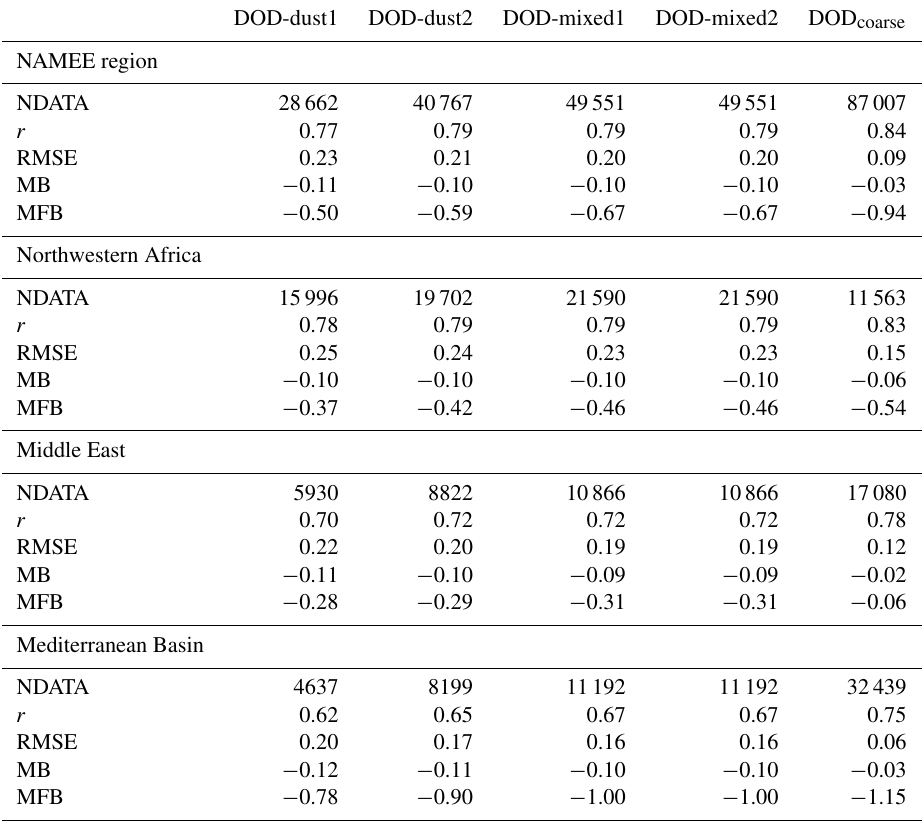
Table 8. Same as Table 7 but using daily reanalysis values and AERONET dust-filtered AOD and AOD coarse averaged on a daily basis as